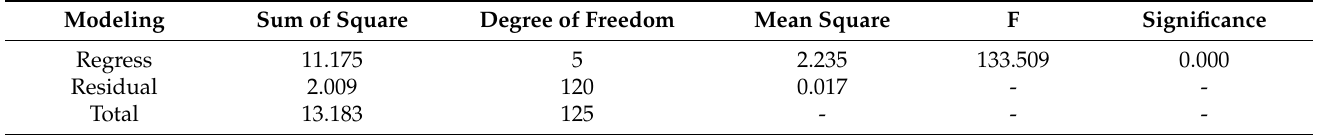
Table 3. Linearity test results of five spectral index models.